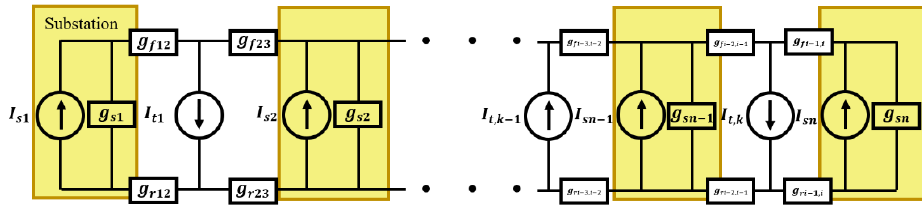
Figure 3. Equivalent circuit diagram of DC power supply system.